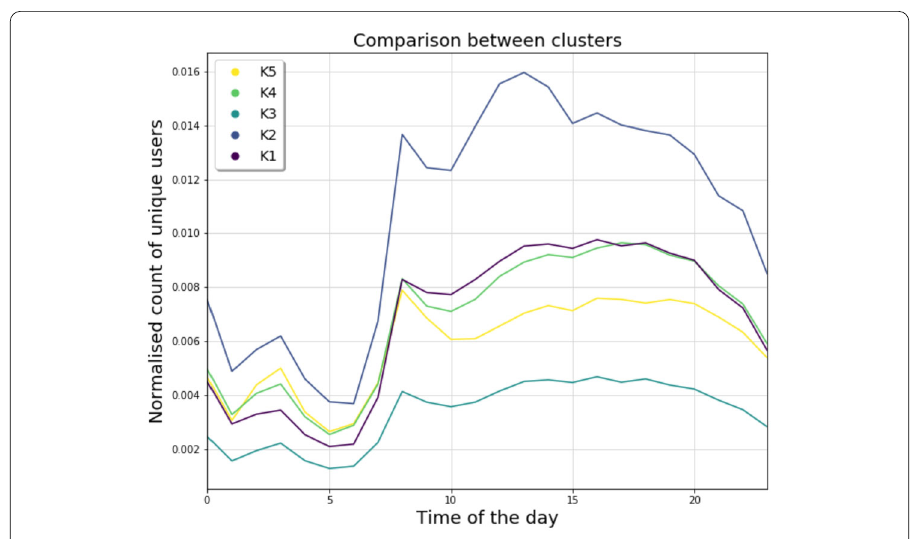
Figure 10 Total connections, detailed per hour and disaggregated by census segment of the area of